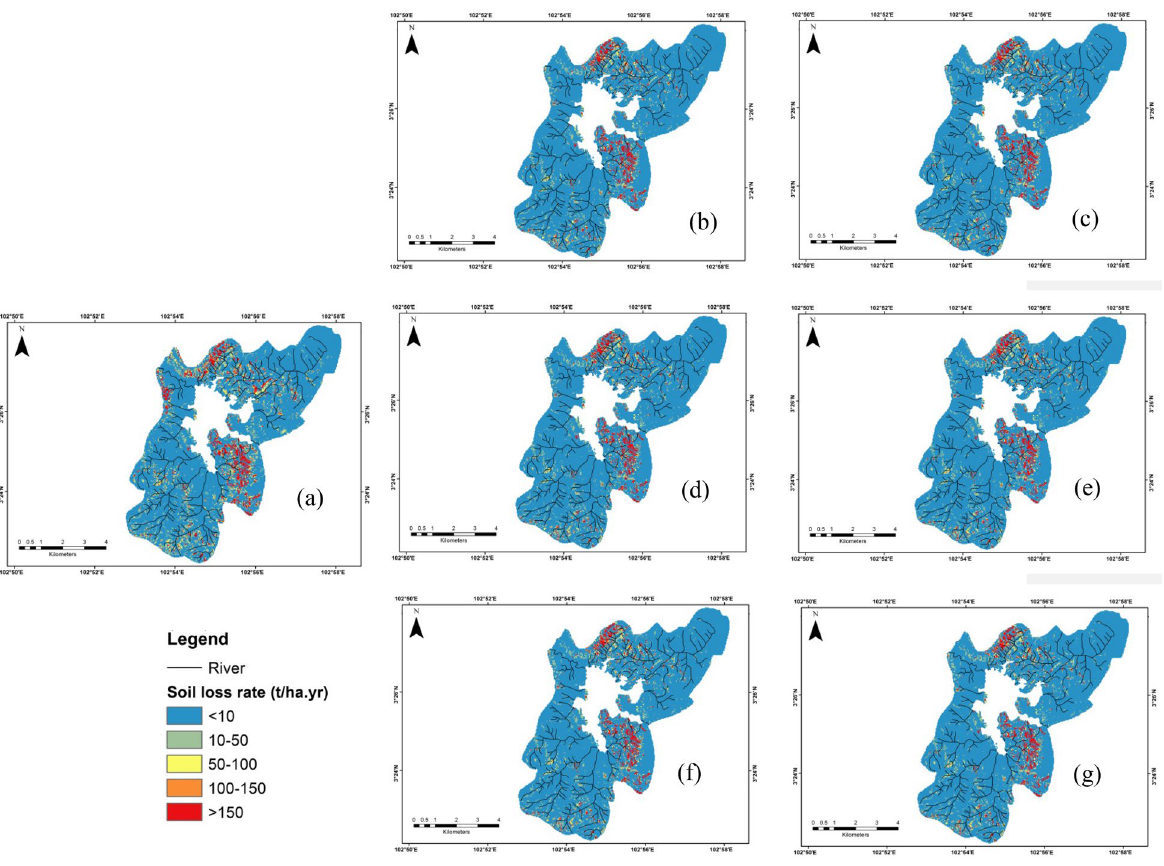
Fig. 8 Estimated future soil erosion changes under distinct scenarios of SSPs ( a ) baseline 2019–2021, ( b ) SSP2.6 (2040–2060), ( c ) SSP2.6 (2060– 2080), ( d ) SSP4.5 (2040–2060), ( e ) SSP4.5 (2060–2080), ( f ) SSP8.5 (2040–2060), ( g ) SSP8.5 (2060–2080)